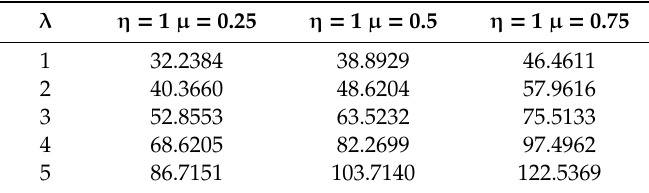
First five natural frequencies for the SFG distribution for three di ff erent states of complete agglomeration.